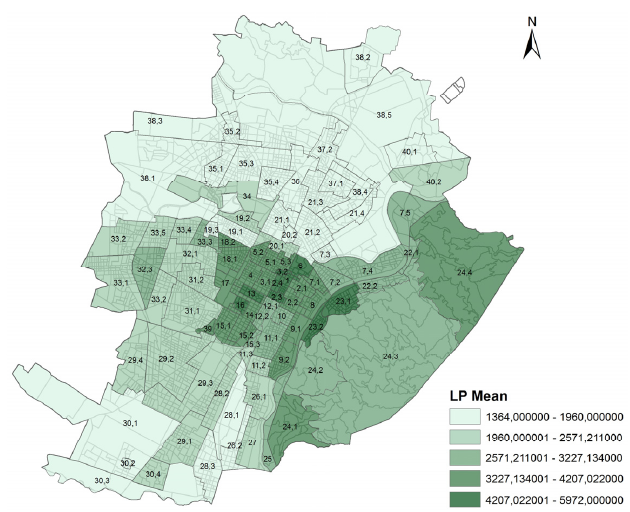
Figure 2. The price means in the 93 Historical Territorial Units (Source: Authors’ elaboration on TREMO data).